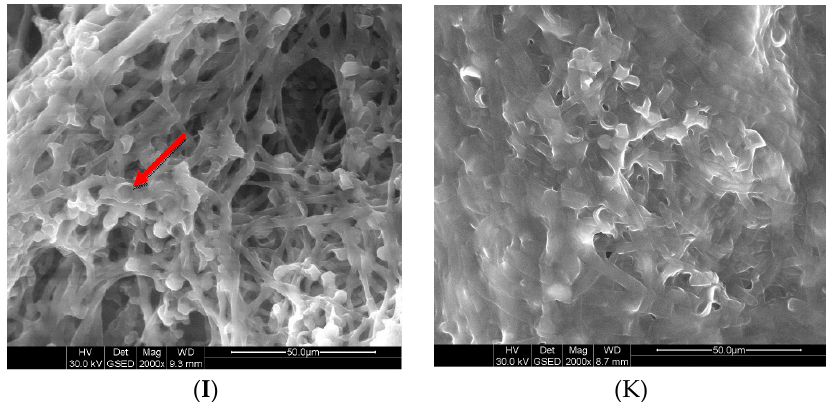
Figure 3. Two days old mycelium: sample with cationic GS C6 at ½ MIC after 24 h ( A ); sample without GS after 24 h ( B ); sample with cationic GS C6 at MIC after 4 h ( C ) and 24 h ( D ); sample with non-ionic GS A6 at MIC after 4 h ( E ) and 24 h ( F ); sample with cationic GS C6 at 2 MIC after 4 h ( G ) and 24 h ( H ); sample with non-ionic GS A6 at 2 MIC after 4 h ( I ) and 24 h ( K ).